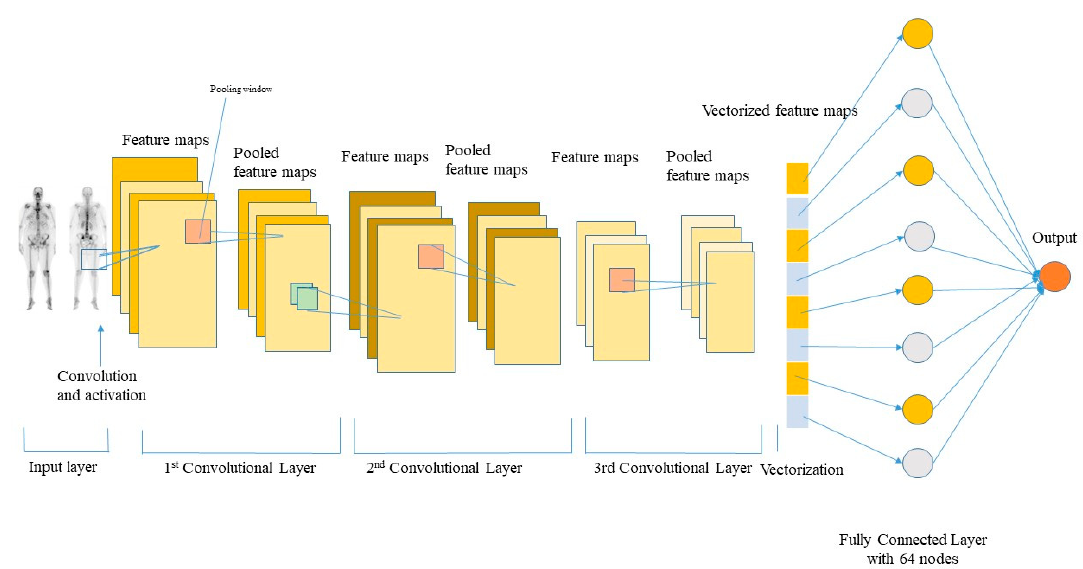
Figure 3. The CNN framework for bone scintigraphy classification.